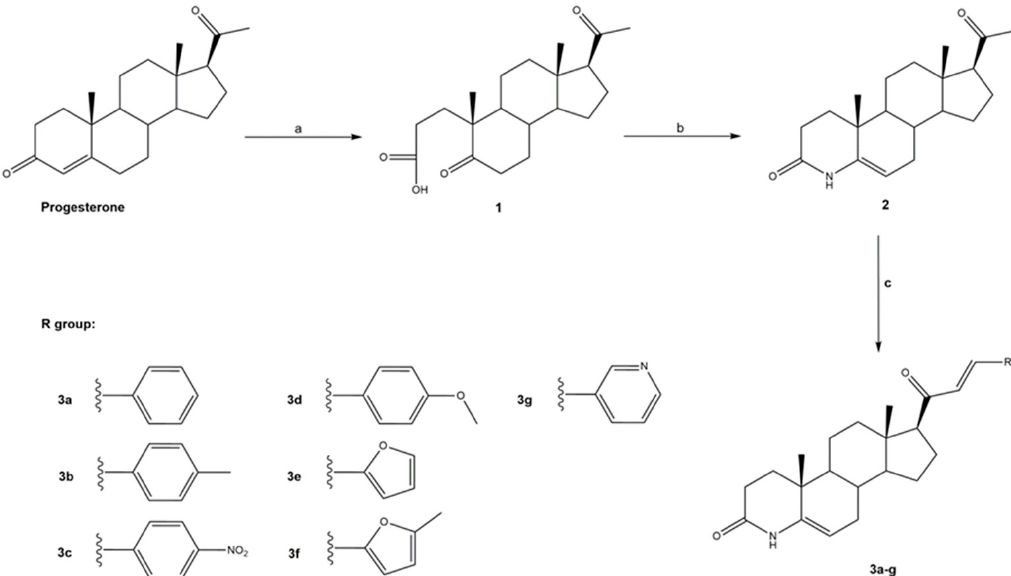
Table 1. New 21-arylidene-4-azapregn-5-ene derivatives synthesized, and respective overall yields (%) 1